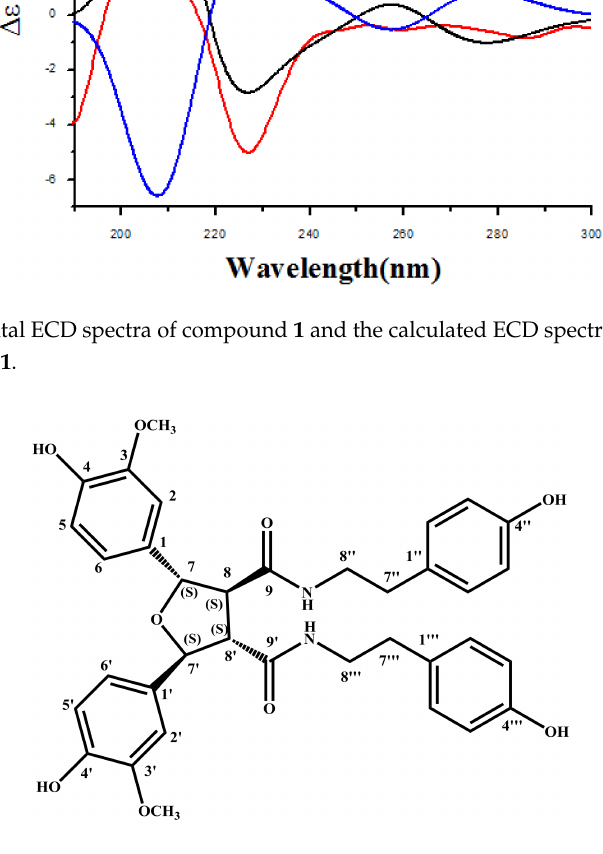
Figure 4. The chemical structure of 1 , indicated the absolute configurations of chiral